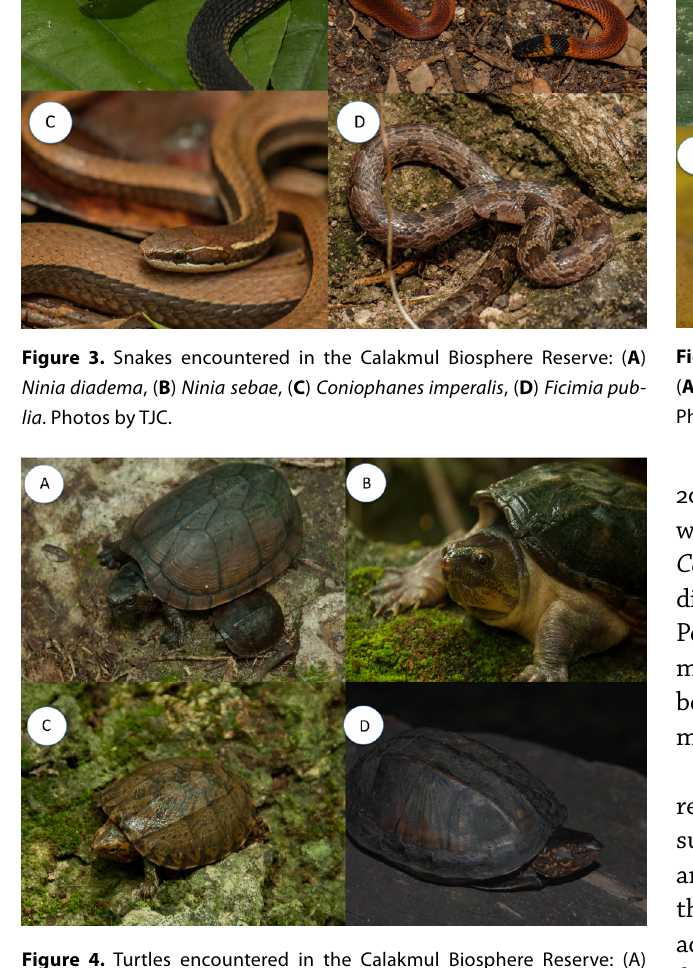
Figure 4. Turtles encountered in the Calakmul Biosphere Reserve: (A) Kinosternon leucostomum ; adult and juvenile, ( B ) Claudius angustatus, ( C ) Rhinoclemmys areolata, ( D ) Kinosternon acutum (Photo by JAB). Photos by